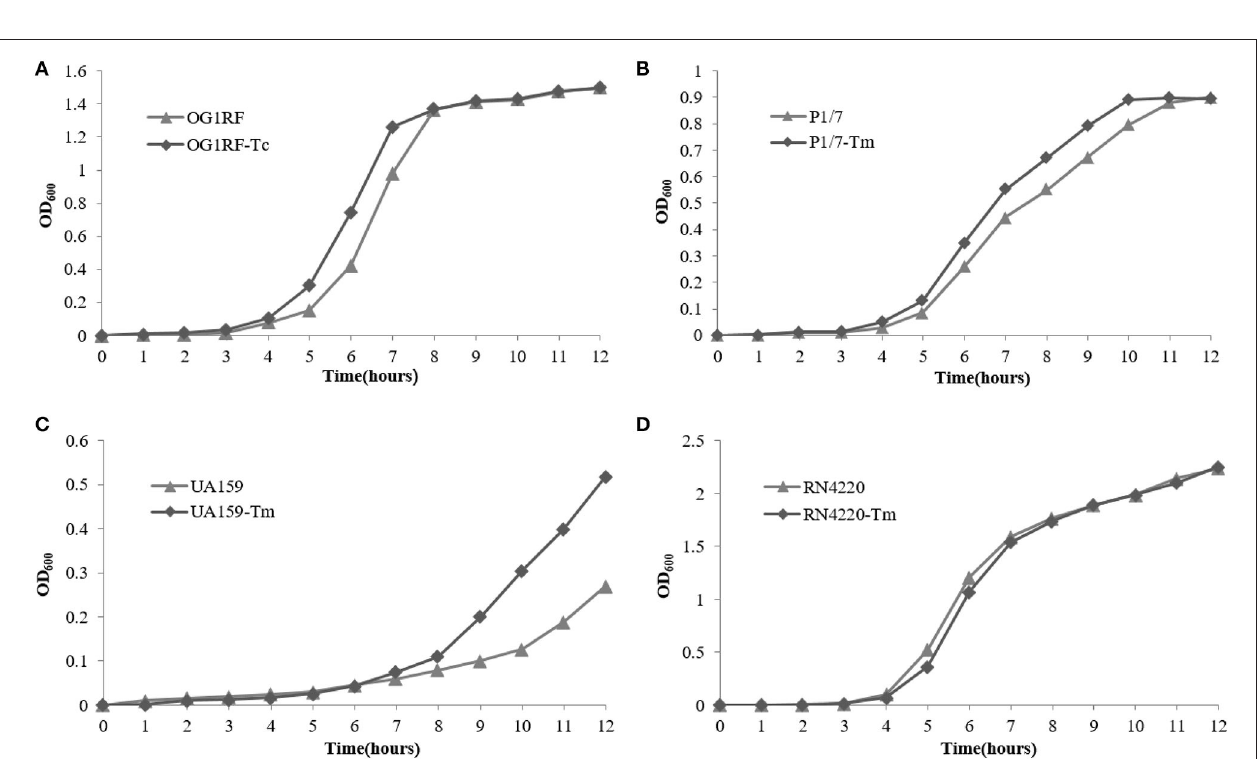
FIGURE 4 | Fitness cost of pE165. (A–D) Comparison of growth kinetics of E. faecalis OG1RF and E. faecalis OG1RF-Tc, S. aureus RN4220 and S. aureus RN4220-Tm, S. suis P1/7 and S. suis P1/7-Tm, S. mutans UA159 and S. mutans UA159-Tm in the absence of erythromycin.